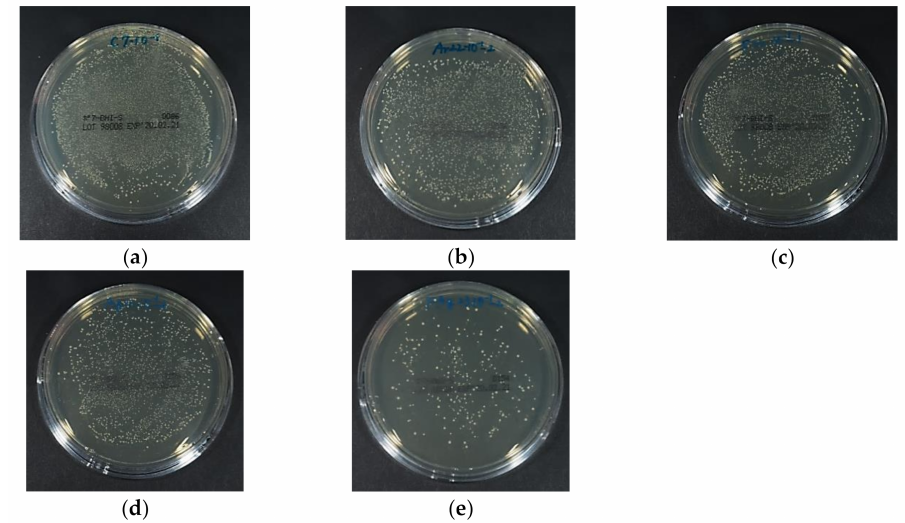
Figure 7. The representative images of the BHI agar medium in which the S. mutans suspension was spread and the colonies were grown. ( a ) Control; ( b ) Ar; ( c ) Ar / F; ( d ) Ar + Ag; ( e ) Ar / F + Ag